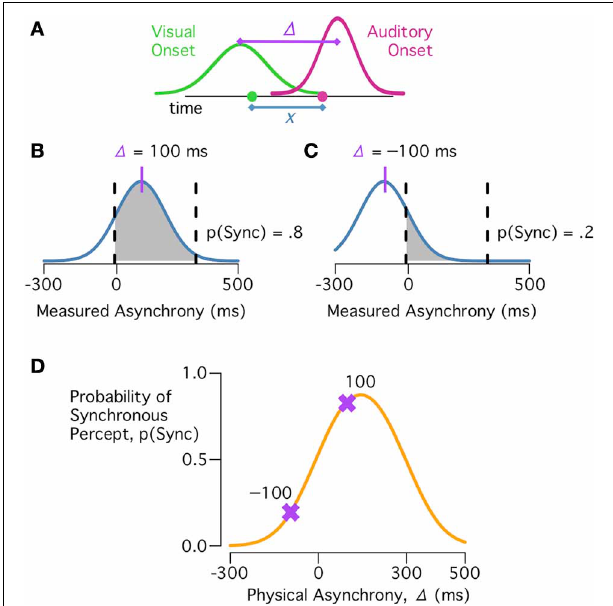
FIGURE 2 | Synchrony judgments under the causal inference model. (A) On each trial, observers obtain a measurement of the audiovisual asynchrony by differencing measurements of the auditory (magenta) and visual (green) onsets. Because of sensory noise, the measured asynchrony ( x , blue) is different than the physical asynchrony ( (cid:2) , purple). (B) For a given physical asynchrony, (cid:2) = 100ms, there is a range of possible measured asynchronies ( x , blue). The shaded region indicates values of x for which C = 1 is more probable than C = 2 ( Figure 1D ). The area of the shaded region is the probability of a synchronous percept, p(Sync). (C) For a different physical asynchrony, (cid:2) = − 100ms, there is a different distribution of measured asynchronies, with a lower probability of a synchronous percept. (D) The probability of a synchronous percept for different physical asynchronies. Purple markers show the predictions for (cid:2) = 100ms and (cid:2) = −